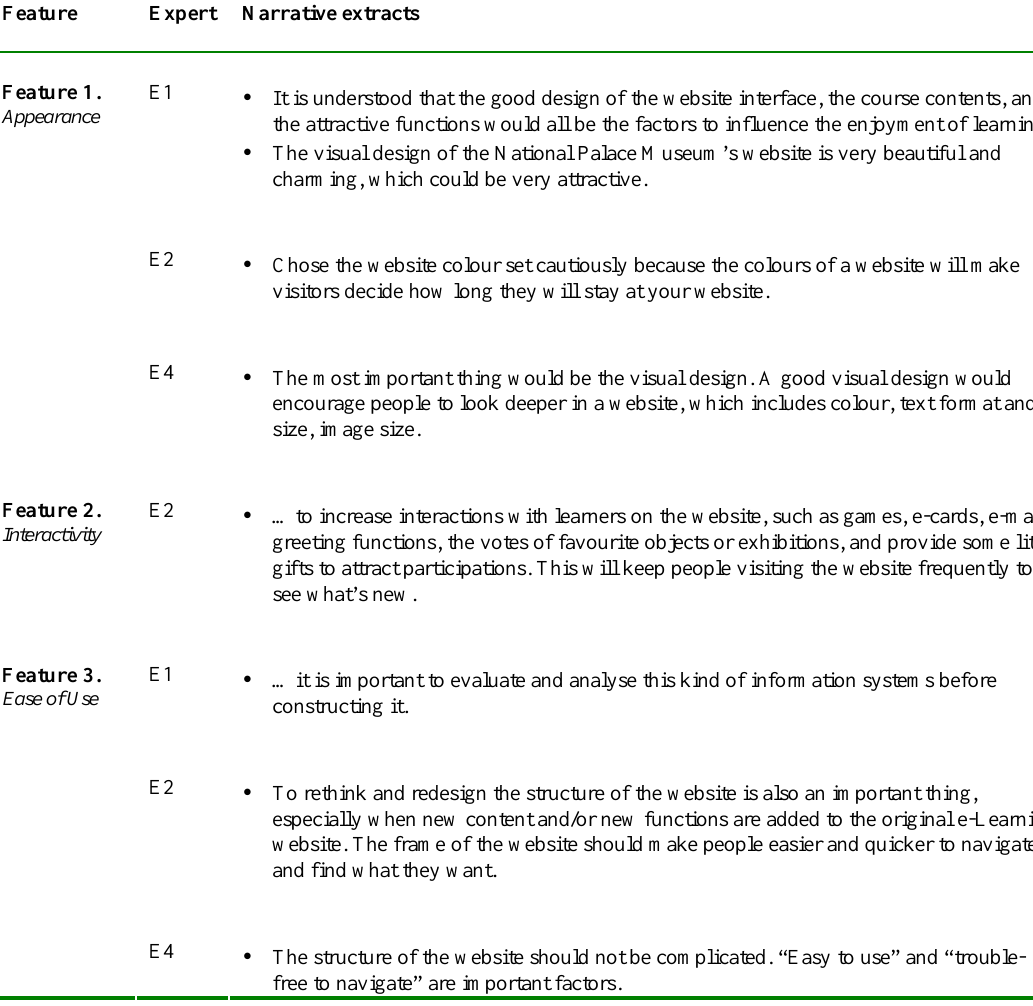
Table 2. Illustrative narrative extracts for features of an e-Learning